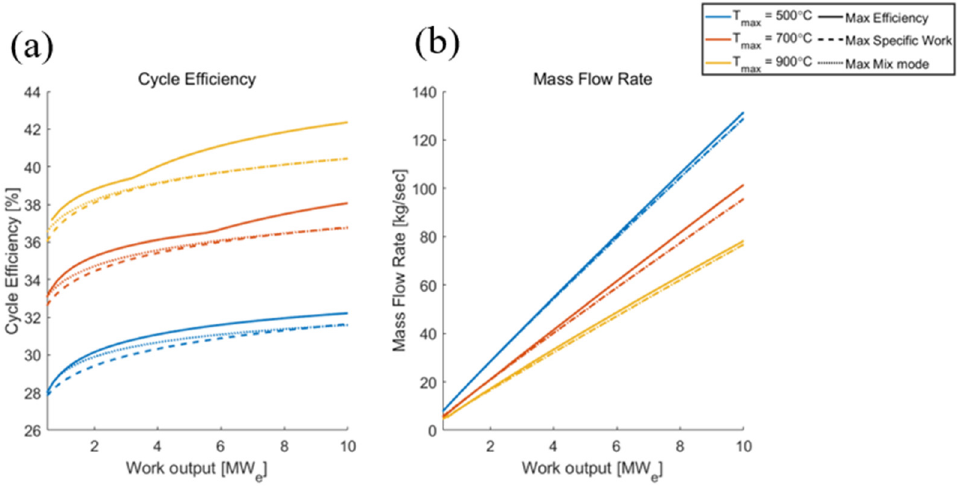
Figure 23. ( a ) Cycle efficiency and ( b ) cycle mass flow rate of S-CO 2 Brayton Cycle.